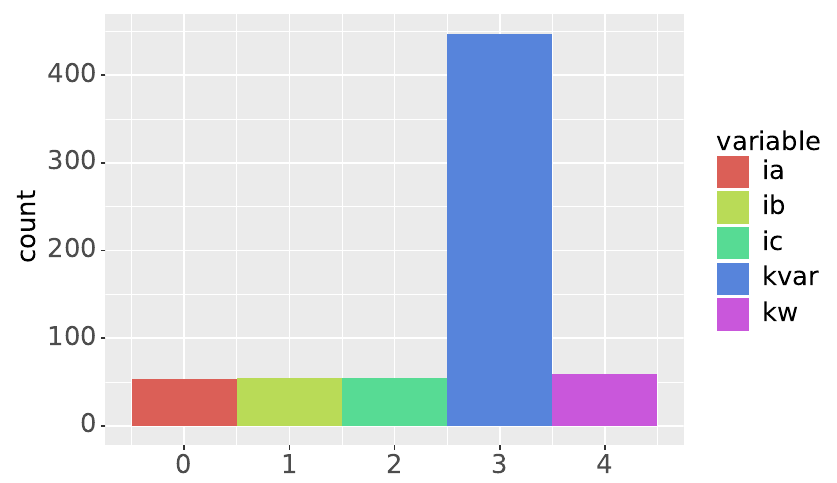
Figure 15. Variables distribution for 10% ≤ SMAPE < 20%.